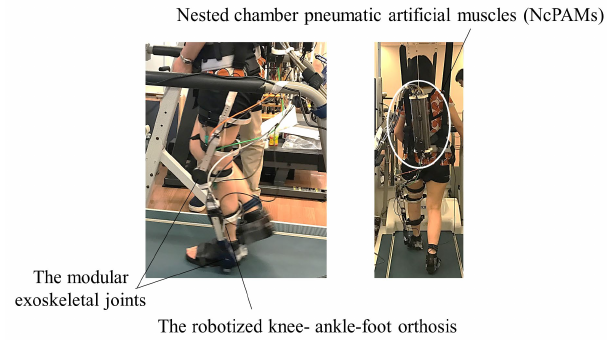
Figure 1. Robotized knee-ankle-foot orthosis. We used a robotized knee-ankle-foot orthosis. The device consisted of an orthosis, Modular Exoskeletal Joints, nested chamber pneumatic artificial muscles (NcPAMs), and a control personal computer. The unit of NcPAMs was carried on the patient’s back and was relieved by a body-weight support device. The four PAMs assisted in knee flexion and extension, ankle dorsiflexion, and plantar flexion. Table 2. The specification of the robotized knee-ankle-foot orthosis.